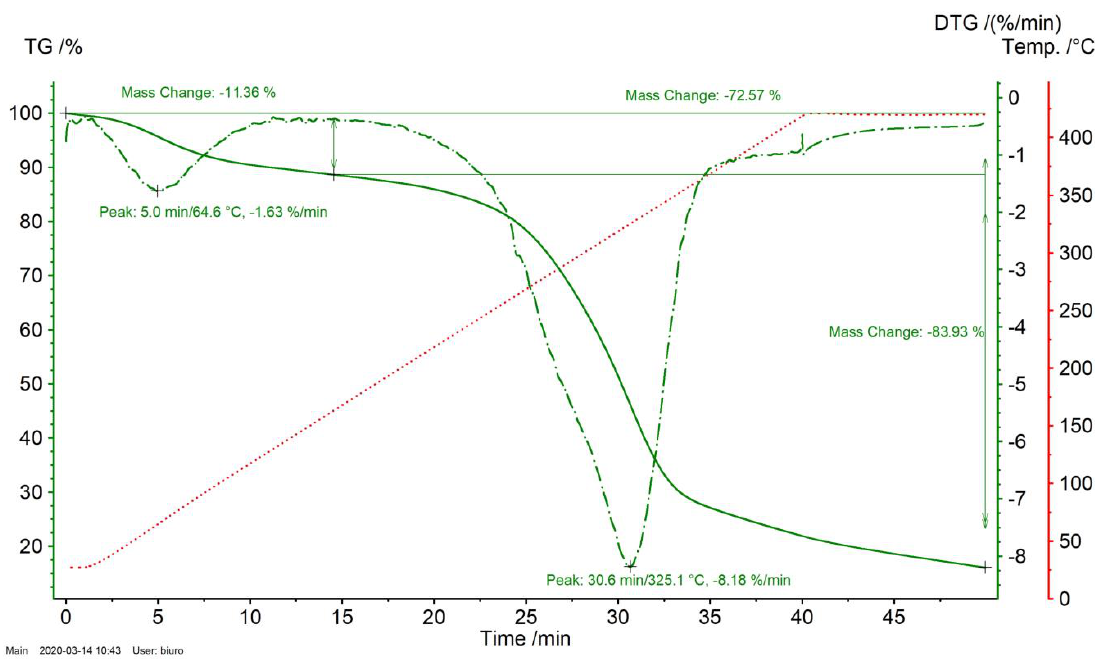
Figure 11. Thermogravimetric analysis of oat straw for the production of carbonized solid biofuel at temperature 420 °C in N 2 atmosphere.